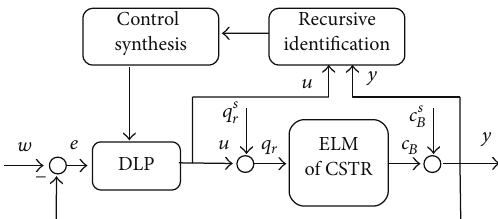
Figure 11: Control scheme of the classic adaptive control.